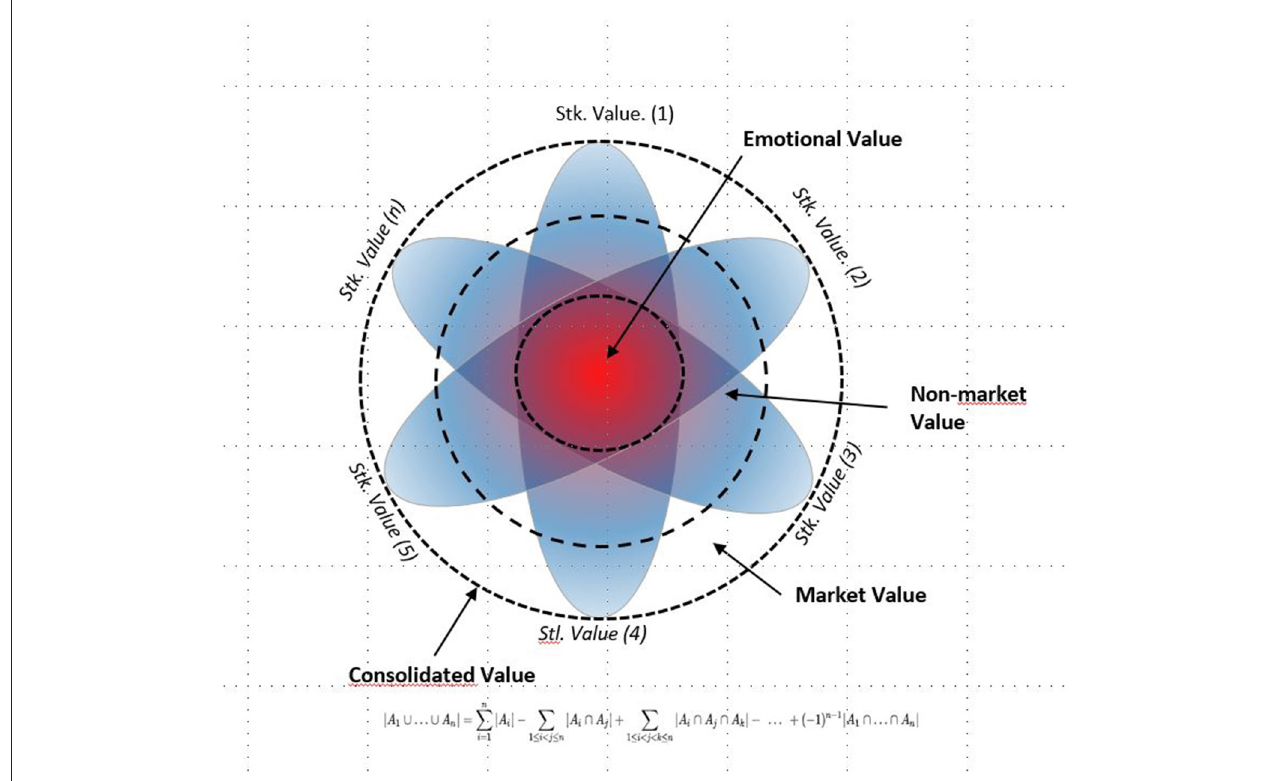
FIGURE 5 | Emotional value in the multifaceted model. Source: Freeman et al. (2020, p. 102).